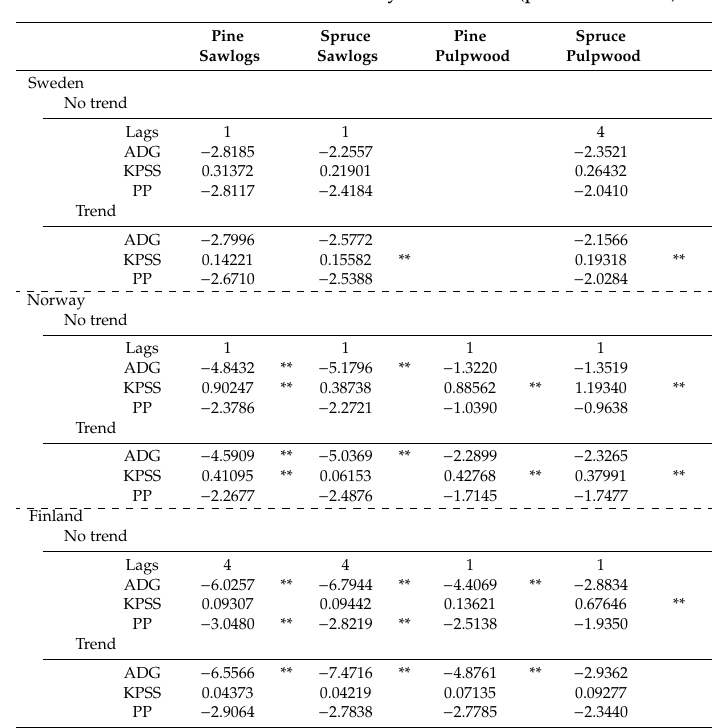
Table A1. Unit root and stationarity test results (prices in levels).